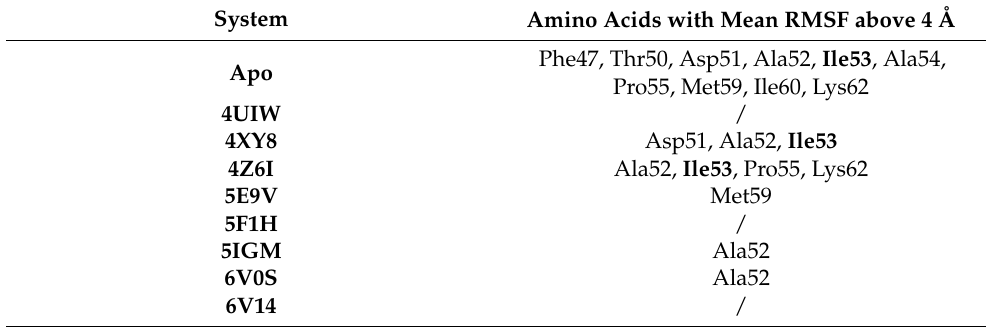
Figure 6. ( a – i ) RMSF of the 9 systems. Each simulation was run independently three times and the data reported are the mean of the backbone and side chains values. Residues with an RMSF above 3.0 Å are labeled, specifically for ( a ) apo -BRD9,